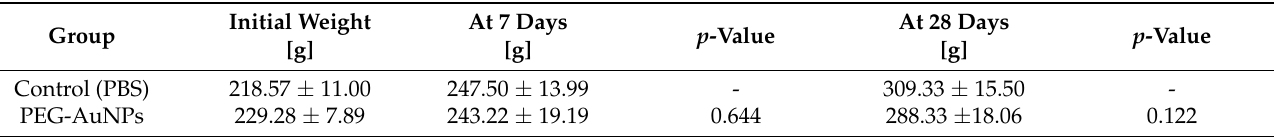
Table 2. Bodyweight of control and PEG-AuNPs-injected